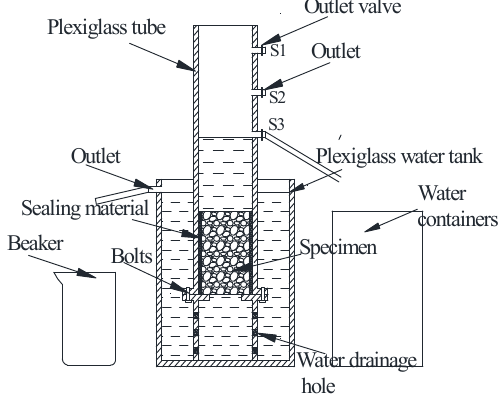
Figure 2. The permeability test device of pervious concrete.